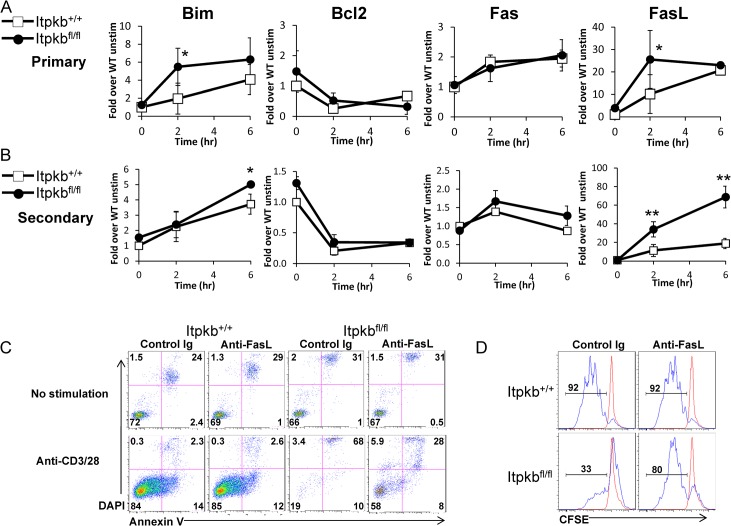
Itpkb negatively regulates pro-apoptotic gene expression and AICD in CD4+ T cells.Either purified (primary) CD4+ T cells (A) or in vitro-expanded (secondary) CD4+ T cells (B) were stimulated with anti-CD3/28 beads for the indicated time points. Following RNA isolation, cDNA was generated, and subjected to real-time quantitative PCR analysis for Bim, Bcl2, Fas, and FasL. The Y-axis represents the respective transcript normalized to either B2-microglobulin or GAPDH values determined for each sample. One representative experiment is shown with the mean values of each genotype ± SE. *, P < 0.05; **, P < 0.01. (C) Purified CD4+ cells were labeled with CFSE and stimulated with anti-CD3/28 beads in the presence of anti-FasL or an isotype control Ig. 72 hours following stimulation, cells were stained with Annexin V and DAPI. Numbers in the lower left quadrant indicate the percentage of live cells at the time of analysis. (D) Proliferation measured by CFSE dilution was followed after 72 hours in culture. Blue and red lines indicate stimulated and unstimulated cells, respectively. Numbers above bracketed lines indicate the percentage of divided cells. Data shown is representative of three independent experiments.